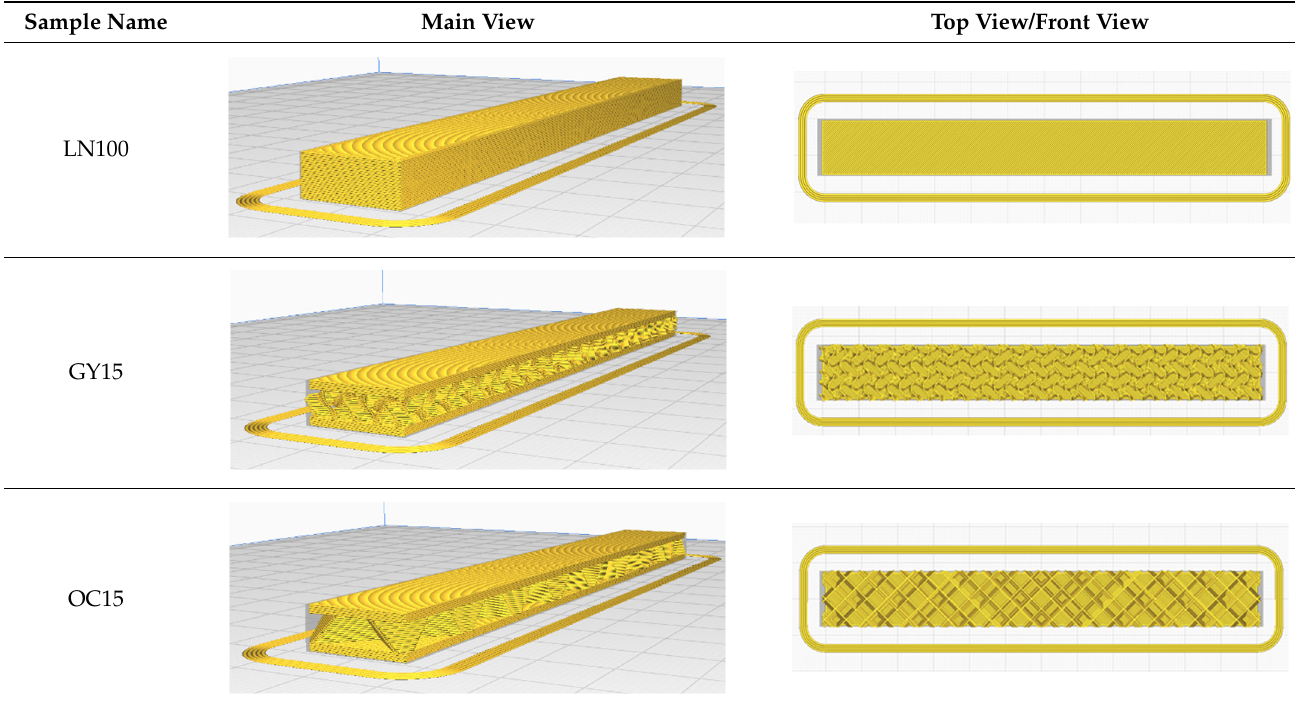
Table 1. Samples under examination in this study.